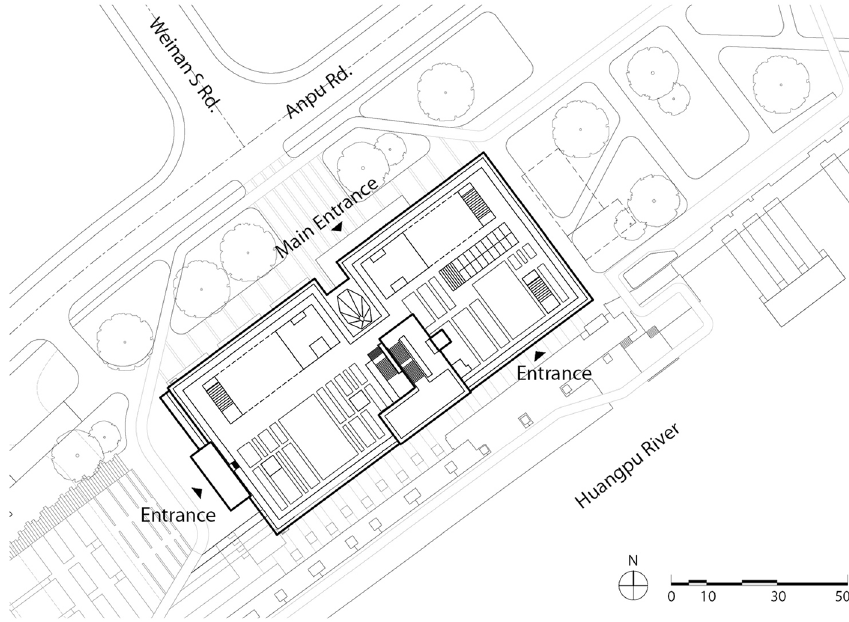
Fig. 2 Yong ’ an Warehouse Masterplan (Source: Archi-Union